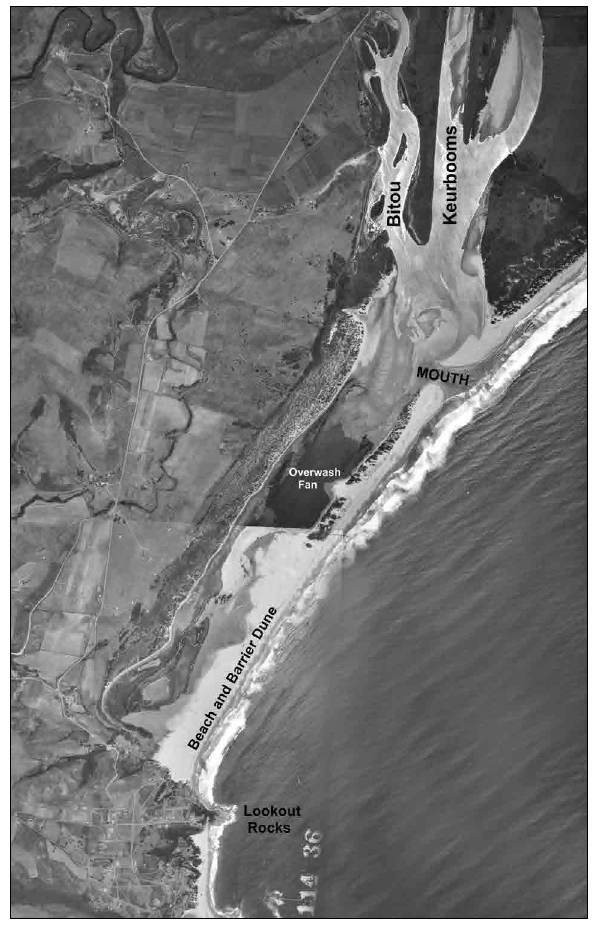
An aerial photograph of the Keurbooms Estuary in 1936. At the time, the mouth was still situated at the northern end of the barrier dune, while a complex system of sandbanks is evident on the estuary side. The barrier dune extending southwards had a sparse collection of vegetation, while a prominent overwash fan is indicated. Farther south, the wide beach/barrier dune seems void of vegetation, with marine sediments extending some distance into the back-barrier lagoon. On the western side there appears to be a number of channels with zostera- covered sandbars.